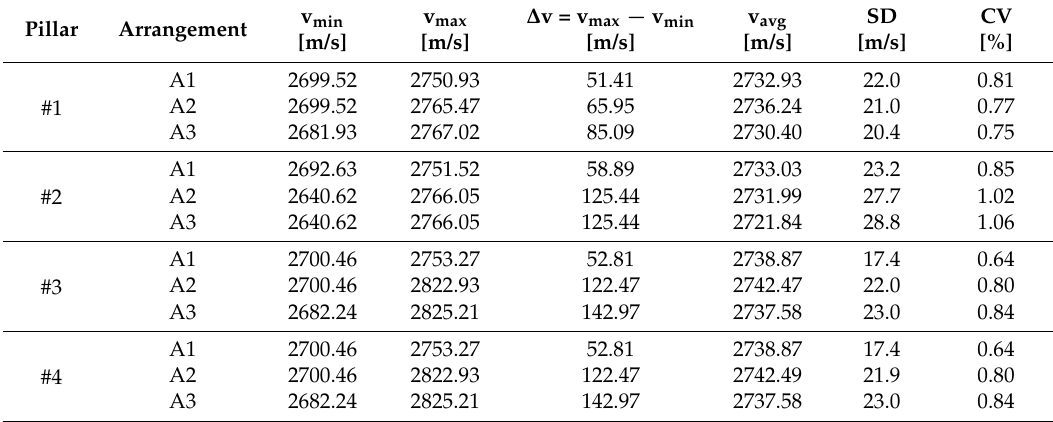
Table 2. Numerical wave propagation velocities for configuration #A.